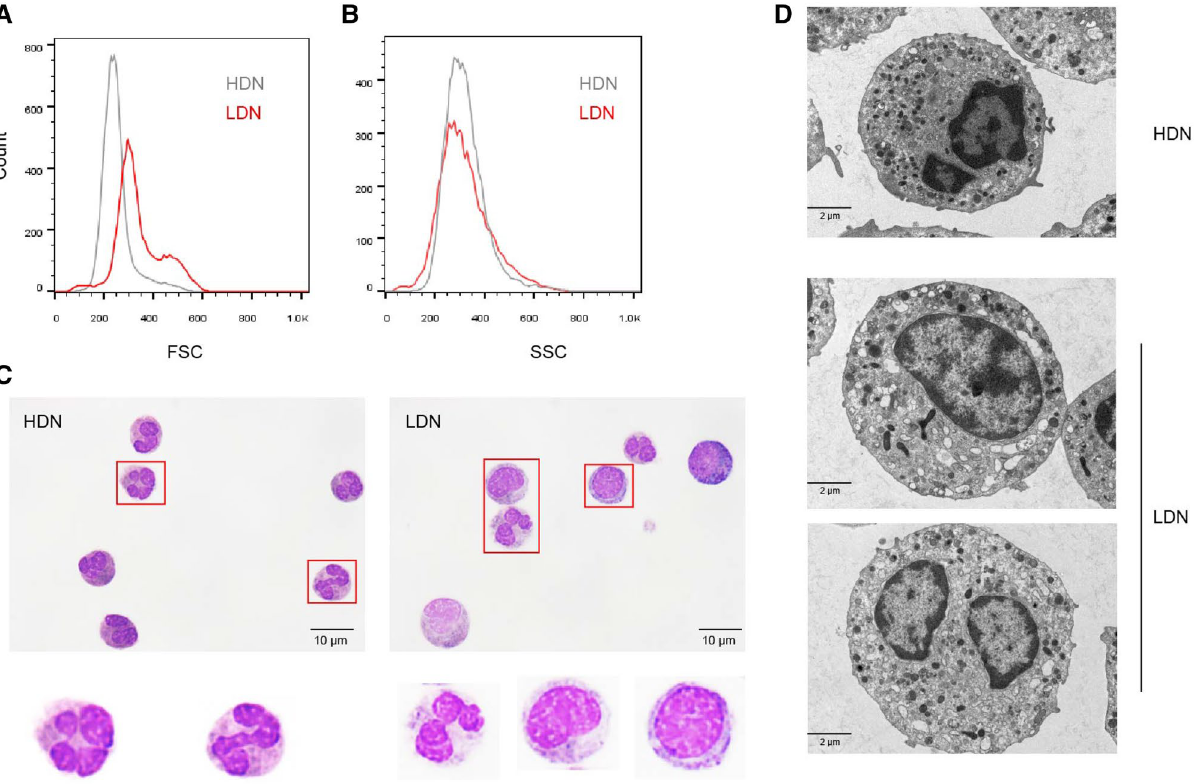
Figure 2. Morphological characteristics of LDNs in sepsis patients. ( A , B ) FACS analysis of LDNs (red) and HDNs (gray) isolated from a sepsis patient showing that LDNs have increased FSC with no change in SSC. ( C ) Representative Wright stain images of HDNs and LDNs. ( D ) Representative transmission electron micrographs of HDNs and